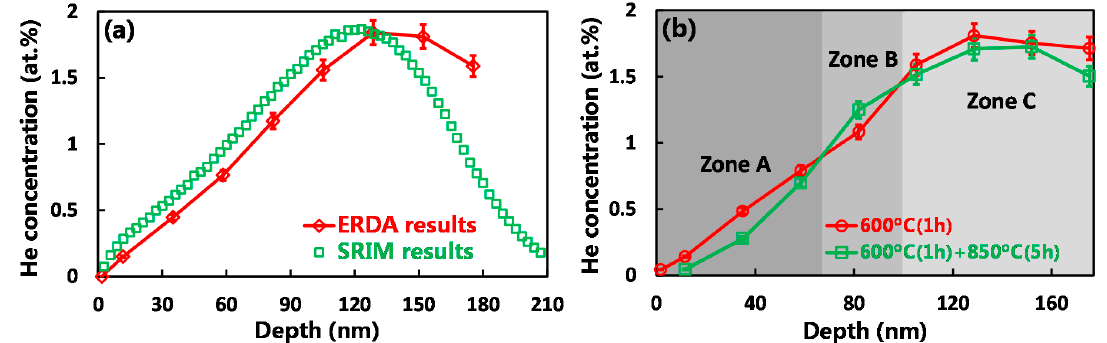
Figure 1. ( a ) Helium concentration depth profiles calculated using elastic recoil detection analysis (ERDA) experiments and SRIM software in Hastelloy N alloy irradiated at 2 × 10 16 ions/cm 2 ; ( b ) Evolution of helium concentration depth profiles on post-irradiation annealing conditions.